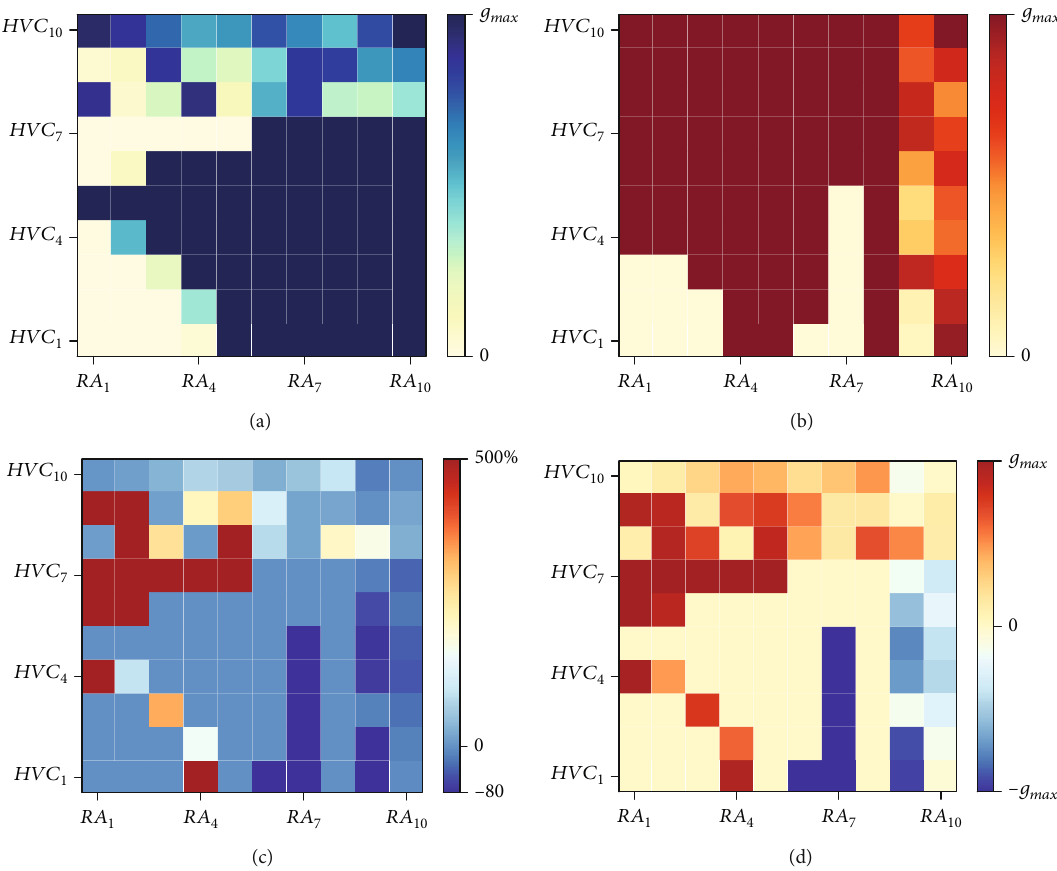
Figure 13: Synaptic conductance matrix and its adjustment caused by deafening during DAF. (a) and (b) show synaptic conductance matrices before and after training with color depth representing conductance intensity. (c) and (d) are adjustment rate and adjustment amount caused by AFP. (c) and (d) show adjustment rate and adjustment amount of synaptic conductance after training. In each subgraph, the square in ( i , j ) represents the synaptic conductance from HVC